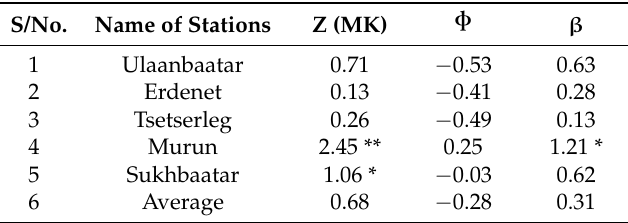
Table 2. The result of Z-statistic of Mann-Kendall (MK), Innovative Trend Analysis Method (ITAM) ( ф ), and Sen’s slope estimator test ( β ). S/No.